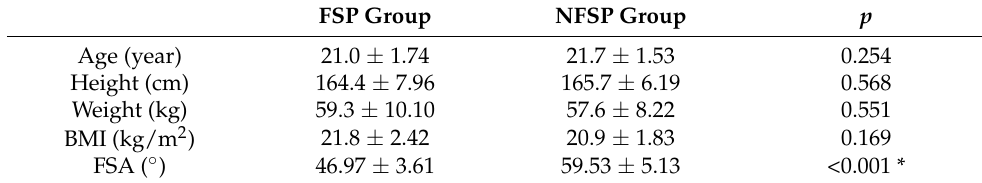
Table 1. General characteristics of the